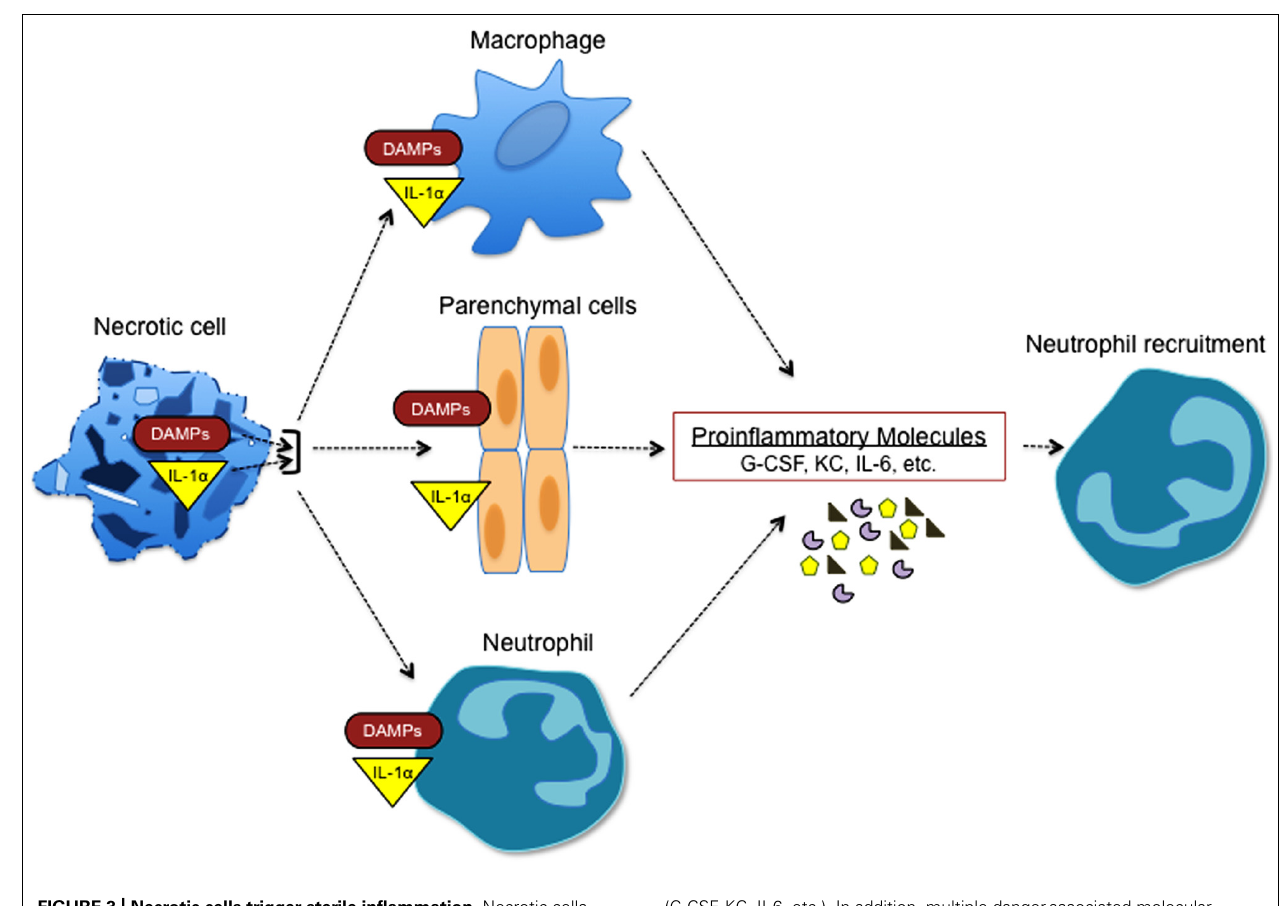
(G-CSF, KC, IL-6, etc.). In addition, multiple danger-associated molecular pattern molecules (DAMPs) including uric acid, reactive oxygen species (ROS), and ATP are released during necrosis and can promote the expression of factors that are involved in inflammation and neutrophil